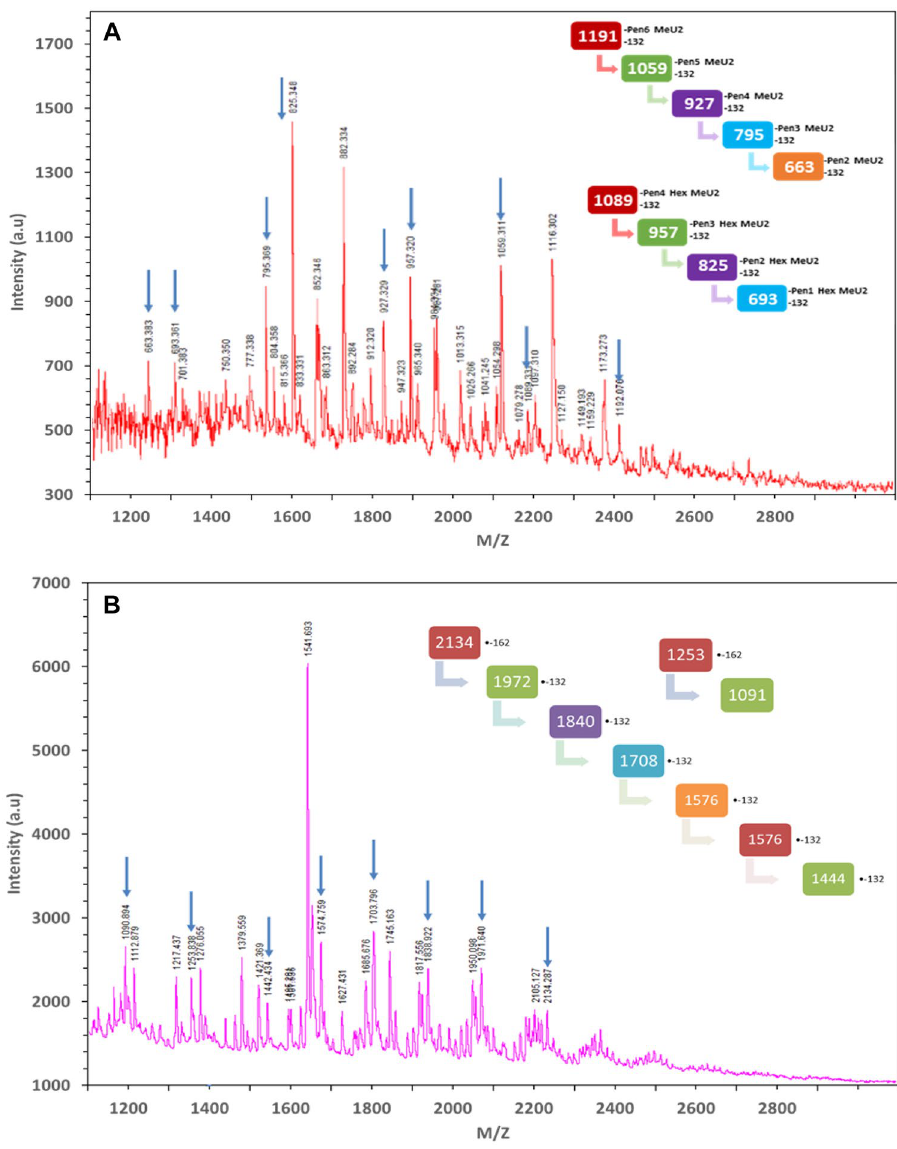
Figure 4. MALDI-MS spectra of soluble recalcitrant oligosaccharides present in ACS. Here, ( A ) ACN-A fraction in low mass range containing glucuronoxylan oligosaccharides with methylated uronic acid substitution (DP 4–8) and ( B ) ACN-B xylan and glucuronoxylan oligosaccharides with methylated uronic acid substitution (DP